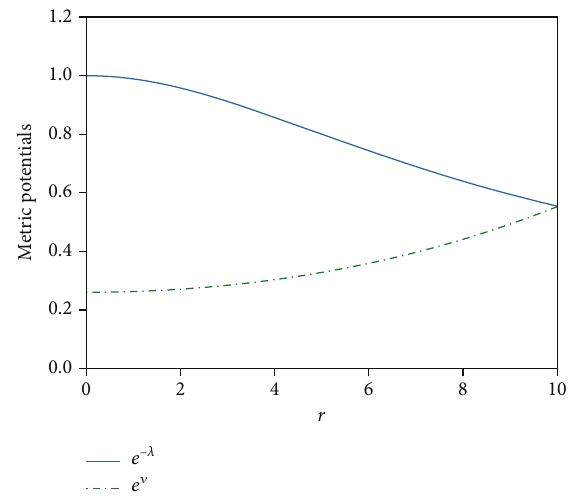
Figure 1: The metric potentials ( e − λ and e ν ) against the radial distance r :